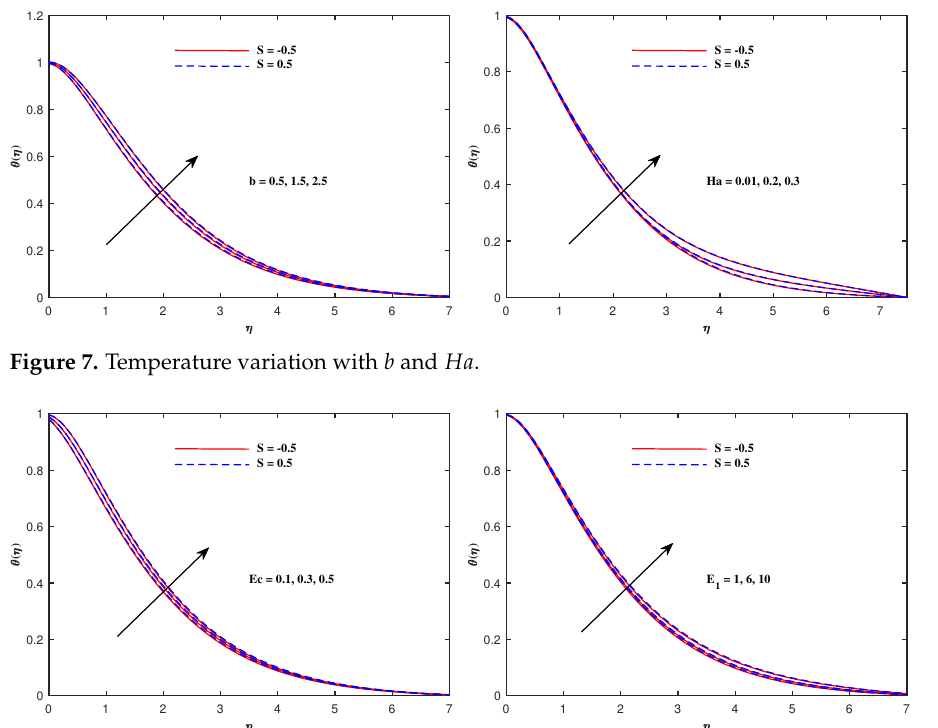
Figure 8. Temperature variation with Ec and E 1 .